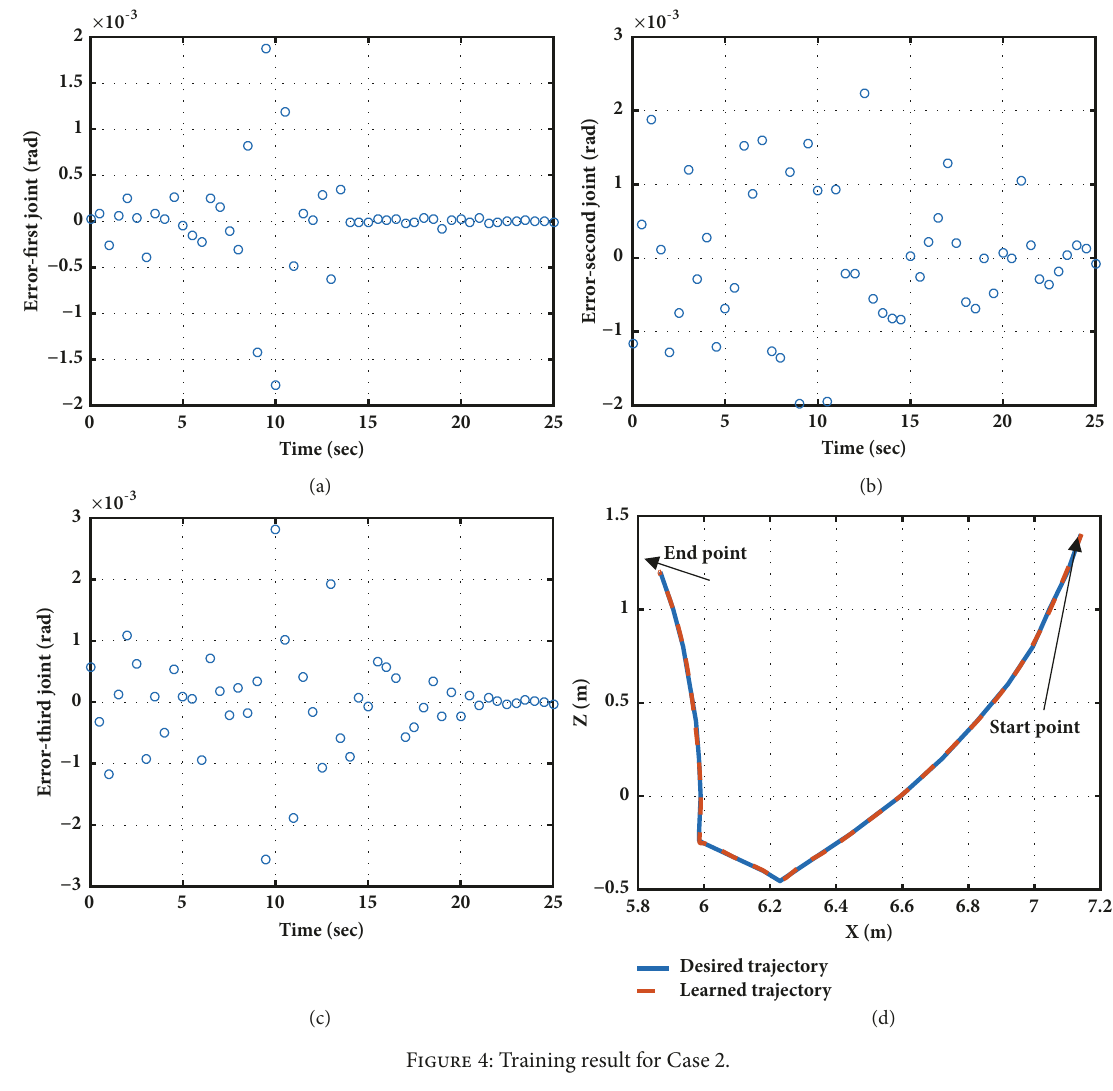
Figure 4: Training result for Case